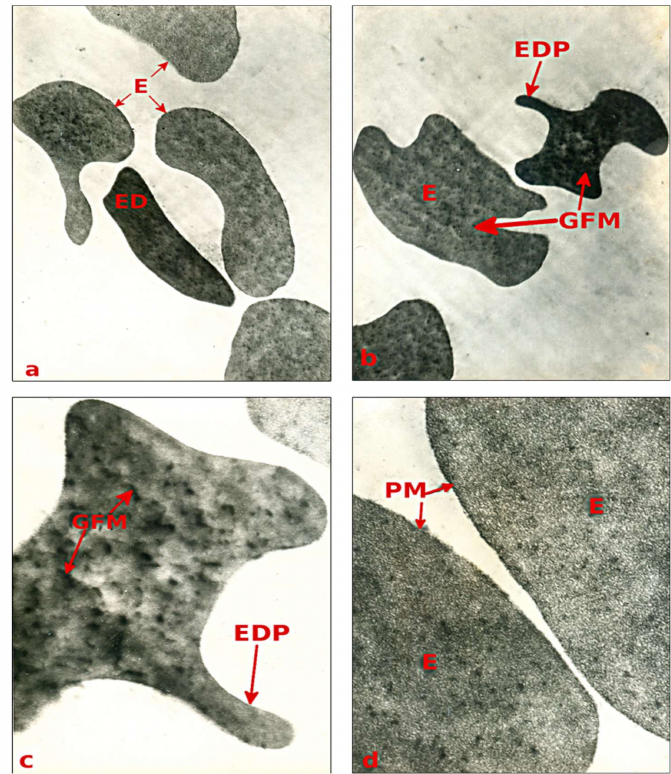
Figure 2. The ultrastructure of peripheral blood erythrocytes in child X, aged 12, with GPP. ( a , b ) erythrocytes (E) of di ff erent shapes and unequal electron density (ED), magnification of 2500 × ; ( c ) an electron-dense erythrocyte with digitiform projections (EDP) and available granulative-fibrillary material (GFM), magnification of 19,000 × ; ( d ) disorganized plasmalemma (PM) in erythrocytes of mean electron density, magnification of 23,000 ×